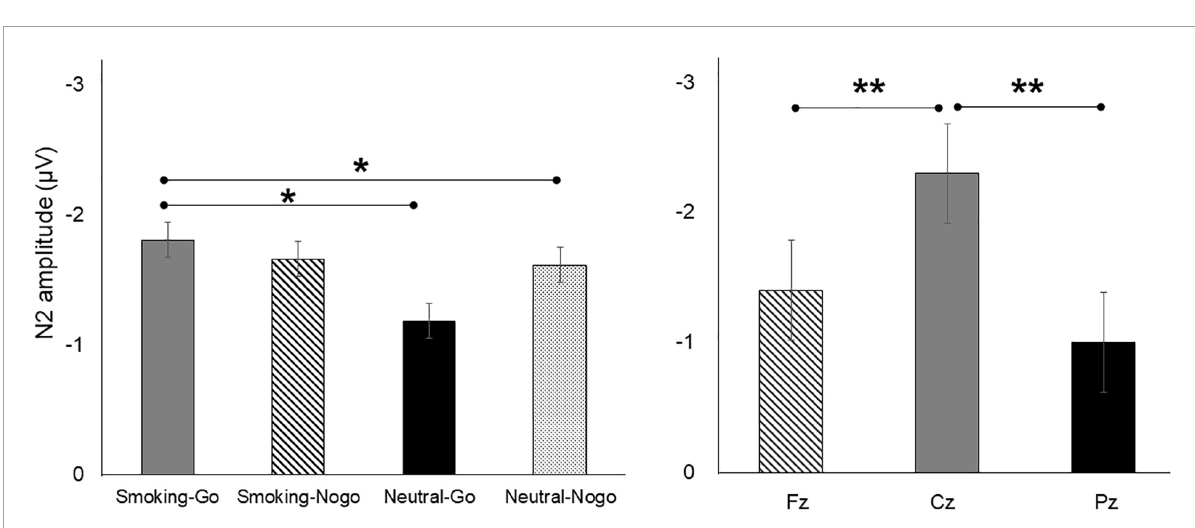
FIGURE2 Differences in N2 amplitudes as a function of stimulus condition and region. * p < 0.05; ** p < 0.01.